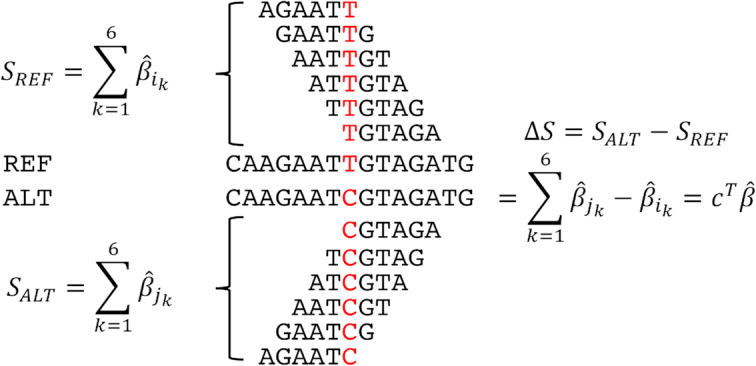
The change in TF binding is computed as a linear combination of the coefficient estimates for all 6-mers overlapping the variant.